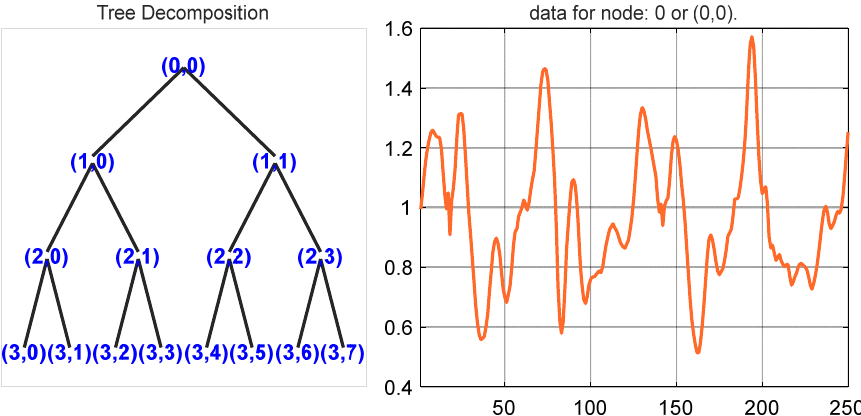
Figure 7. Wavelet packet entropy (two ‐ level) decomposition for the inertial data (for walking data from the USC ‐ HAD dataset).